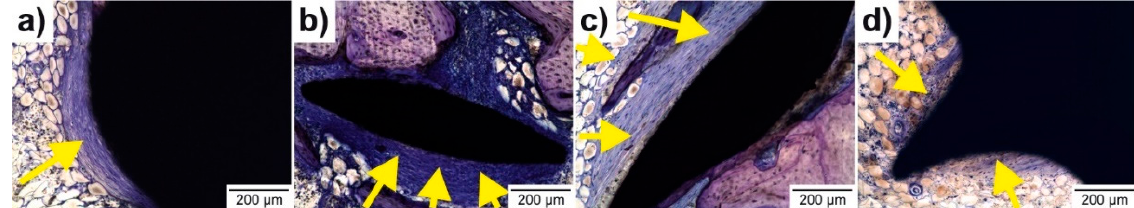
Figure 9. Peri ‐ implant fibrosis (fibrosis is marked by yellow arrows) ( a ) 120 days after experimental screw implantation, ( b ) 240 days after experimental screw implantation, ( c ) 360 days after experimental screw implantation, ( d ) 360 days after Ti ‐ based screw implantation.